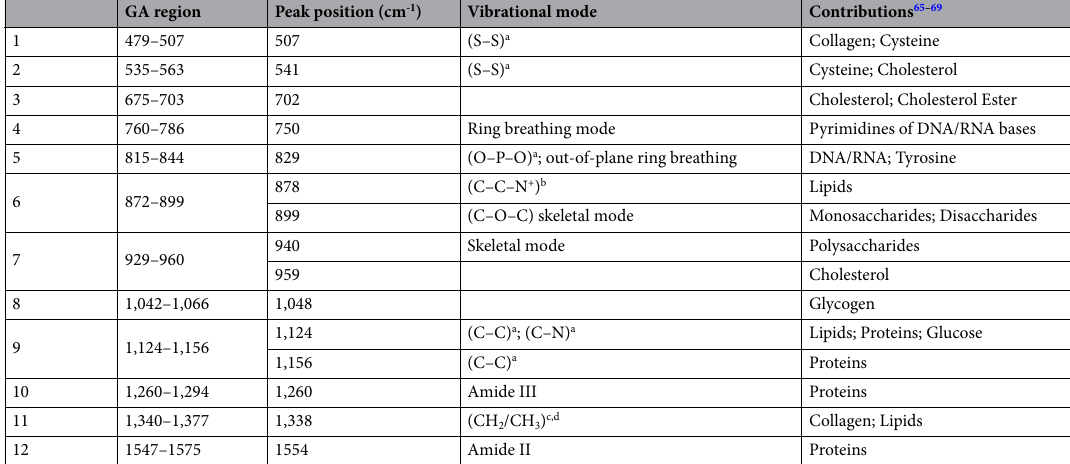
Table 2. Tentative assignments of the most important regions in the Raman spectrum of blood serum for discrimination between control and MDX mice, as determined by GA. a Stretching. b Symmetric